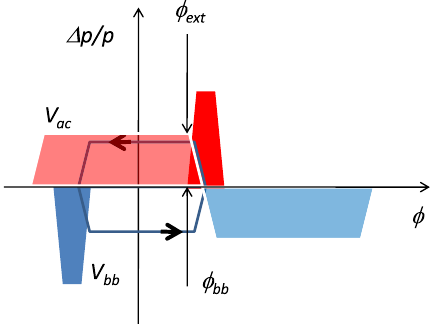
FIG. 13. Phase space with the V ac profile adjusted for